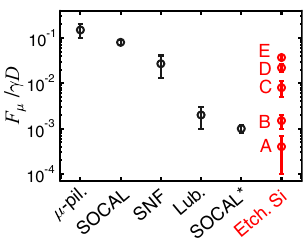
Fig. 4 Comparison between the friction on different liquid-repellent surfaces. The dimensionless friction force measured on: a micropillared ( μ -pil.) surface with a solid fraction of ~0.1 from ref. 9 , a SOCAL surface (in air) at drop speeds of ~0.05mms − 1 from ref. 9 , a silicone nano fi lament (SNF) surface at drop speeds of ~0.2mms − 1 from ref. 19 , a lubricated surface at a capillary number of ~10 − 5 from ref. 9 , a water-immersed polyzwitterionic brush (SOCAL*) surface with an oil droplet moving at a capillary number of ~10 − 7 from Ref. 20 , and our etched silicon (Etch. Si) surfaces (samples A-E). The error bars for our etched silicon data (red markers) are error propagations including the standard deviations of F μ and D (see Supplementary Note 2). The data from our experiments on the etched silicon surfaces are averages from n = 56 (A), 19 (B), 17 (C), 23 (D), and 17 (E) independent experiments performed repeatedly on the same